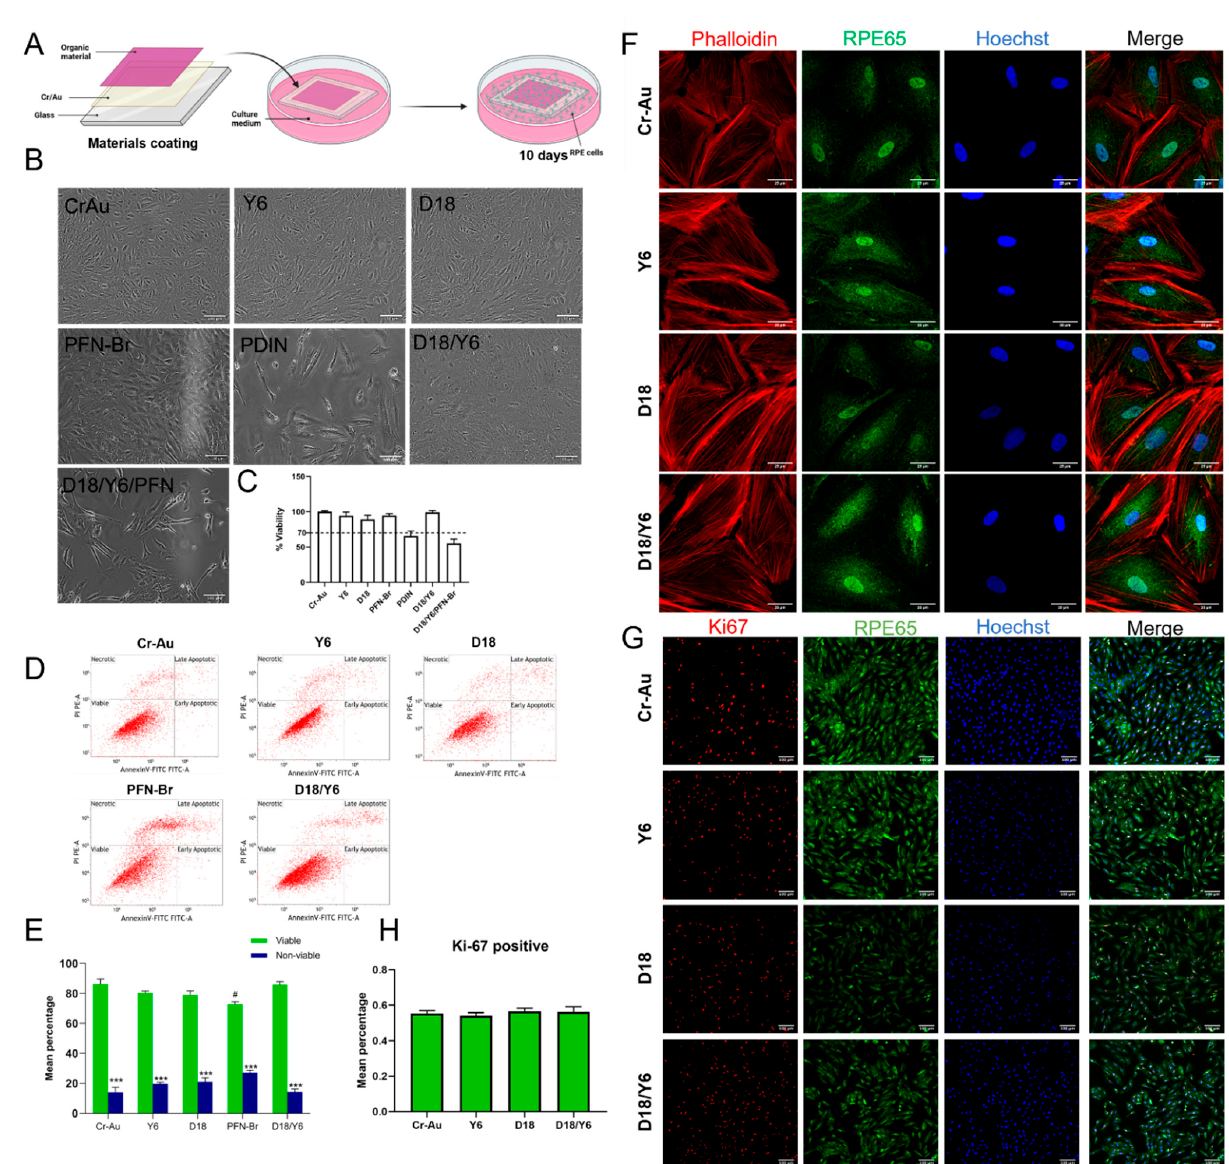
Figure 3. Cytotoxicity of Y6, D18, PFN-Br, PDIN, D18/Y6 and D18/Y6/PFN-Br by direct contract with human RPE cells. ( A ) Schematic representation of the direct contact procedure (created with Biorender.com). ( B ) RPE-19 cell line cultured directly on the glass-coated materials for 10 days, shown as phase contrast images. ( C ) Percentage of RPE cell viability investigated by MTT assay after 10 days of culture with each material ( n = 3). The 70% dotted line represents the minimum viability threshold of a safe material according to ISO standards. ( D ) Representative flow cytometry plots from each material after staining with the apoptotic marker annexin V and the necrotic marker propidium iodine (PI). ( E ) Mean percentage of the number of viable and non viable cells (apoptotic and necrotic) from 3 independent flow cytometry experiments on RPE cells with direct contact with the materials. *** p < 0.001 as compared to viable; # p < 0.05 as compared to viable Cr–Au. ( F , G ) Immunofluorescence images of RPE cells stained against the filament actin marker Phalloidin, the RPE cell marker RPE65, the proliferation marker Ki67 and the nuclei marker Hoechst. ( H ) Mean percentage of Ki-67-positive cells to the total number of cells. Scale bar 100 µm for ( B , G ) and 25 µm for ( F ). RPE, retinal pigment epithelium; PI, propidium iodine.